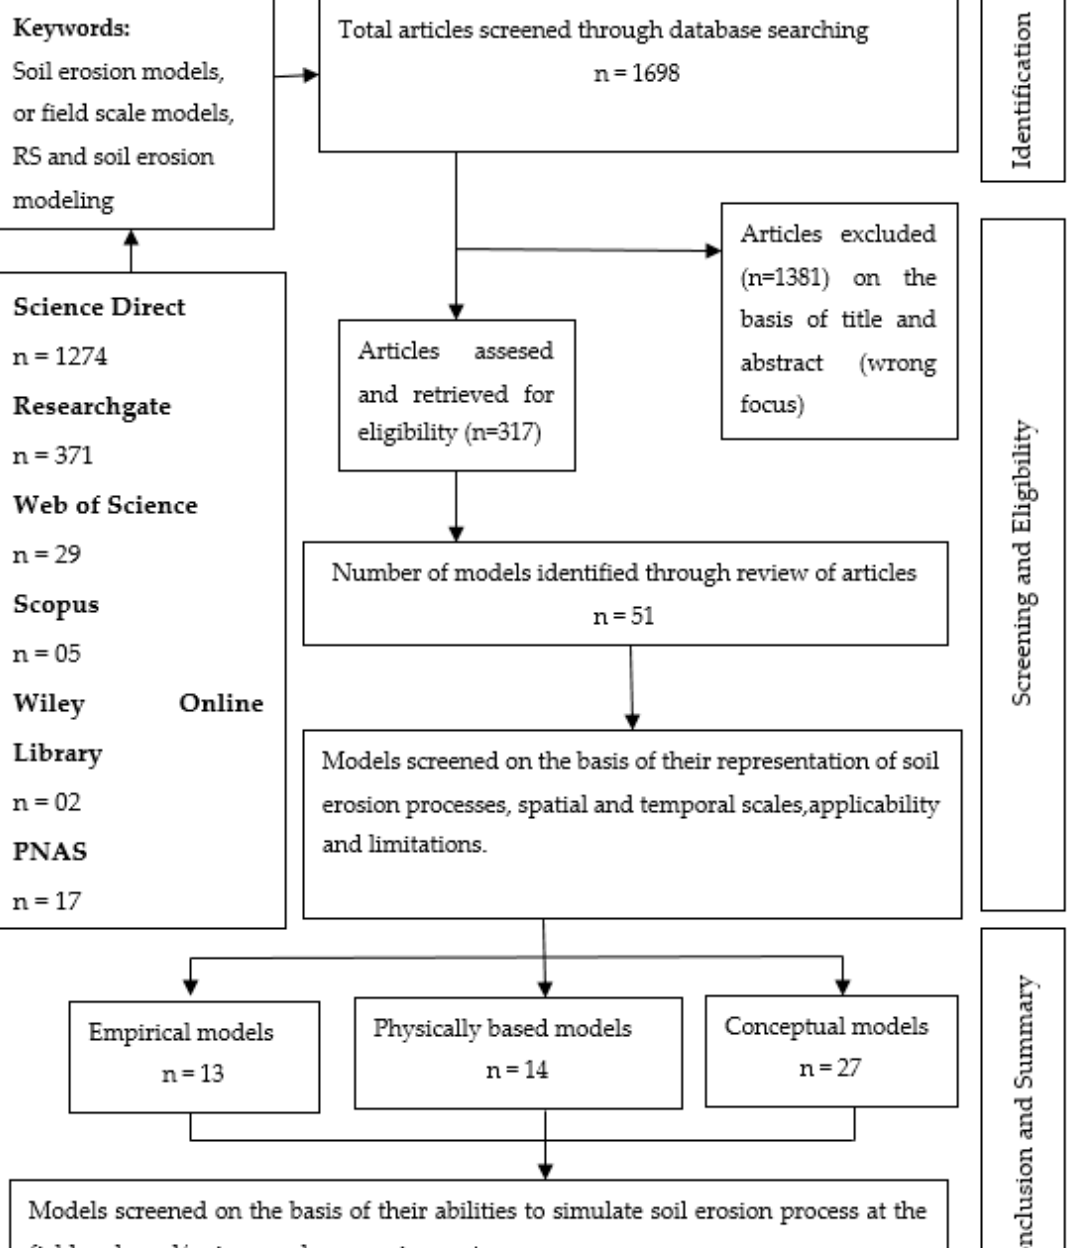
Figure 1. The literature study flow